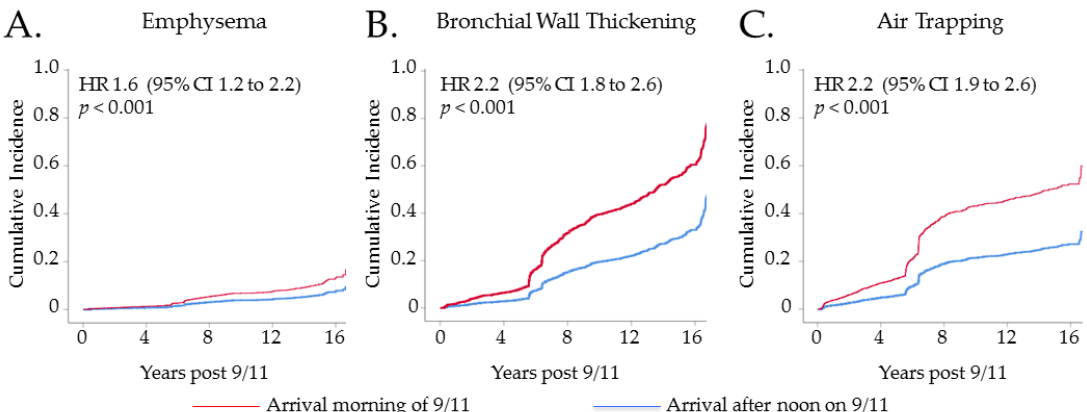
Figure 3. Cumulative incidence of chest CT diagnosis according to WTC exposure intensity. ( A ) shows the cumulative incidence of emphysema in participants who arrived morning of 9/11 at the WTC site (red line) compared with those who arrived between the afternoon of 9/11 and 24/9/2001 (blue line). ( B ) shows the cumulative incidence of bronchial wall thickening in those who arrived morning of 9/11 (red) and those who arrived later (blue). ( C ) shows the cumulative incidence of air trapping in participants who arrived morning of 9/11 (red) and those who arrived later (blue).